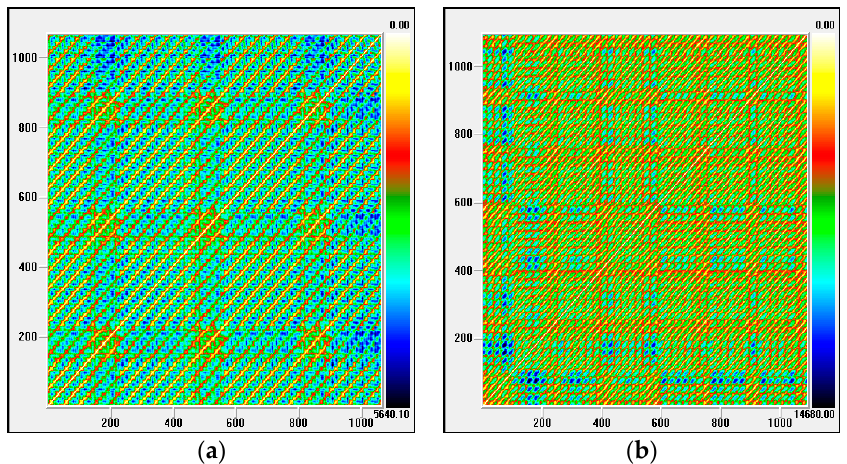
Figure 4. The recurrence plot for Examples 1 and 2. ( a ) Example 1 embedding dimensions = 4; time delays = 13; recurrence rate = 33.3%; laminarity = 51.0% (Small data size from Australian New South Wales, NSW); ( b ) Example 2 embedding dimensions = 4; time delays = 4; recurrence rate = 38.1%; laminarity = 54.7% (Small data size from American New York Independent System Operator, NYISO).